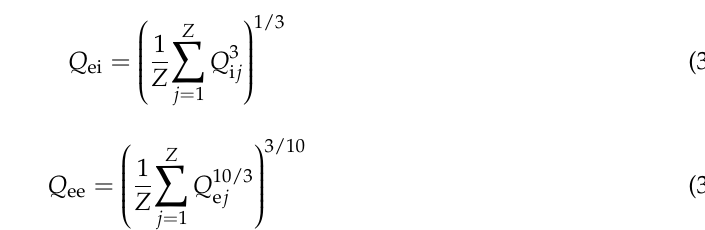
in which the subscripts i and e refer to the inner and outer ring. The basic dynamic load rating of the inner and outer rings,